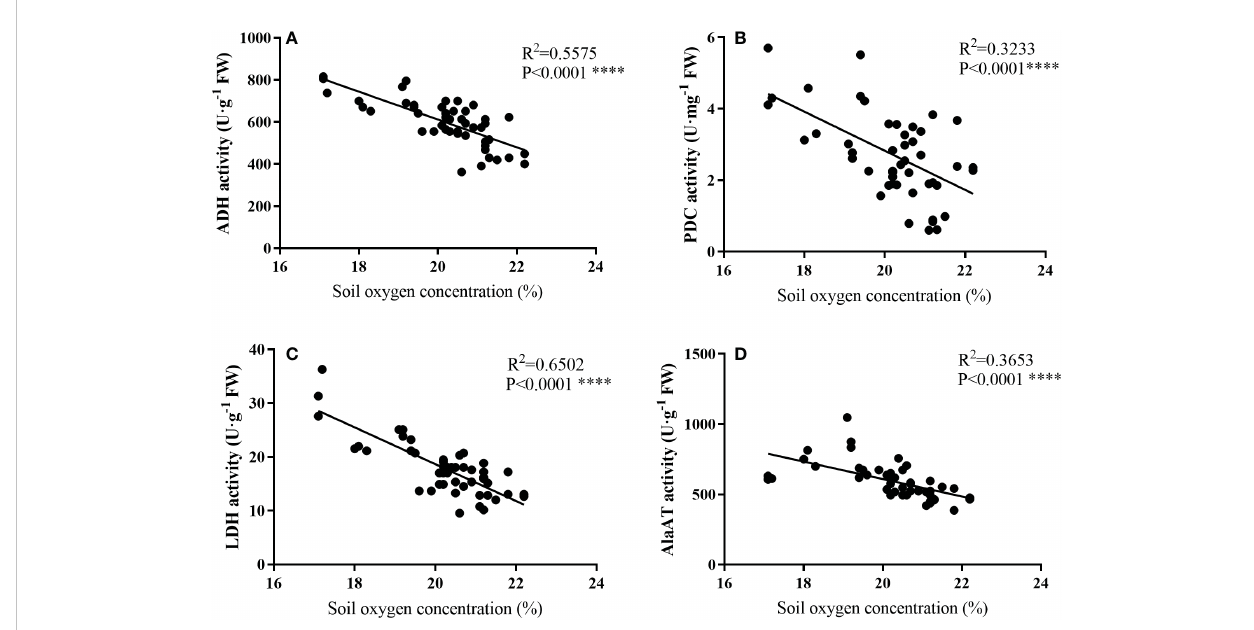
FIGURE 6 Relationships between soil oxygen concerntration (%) and the activities of ADH (A) , PDC (D) , LDH (C) , and AlaAT (D) of bamboo roots under mulching conditions (Control, Mulching, Aeration, M + A). Data are from Figures 1 and 3 and represent mean values. Regression equations are Y = -66.22X 1 + 1936, Y = -0.5478X 2 + 13.78, Y = -3.426X 3 + 87.18 and Y = -62.03X 4 + 1850, respectively, for (A – D) (Y is the soil oxygen concerntration, and X 1 , X 2 , X 3 , and X 4 represent ADH, PDC, LDH, and AlaAT, respectively). R 2 is determined as the coef fi cient of determination. ( p < 0.01,